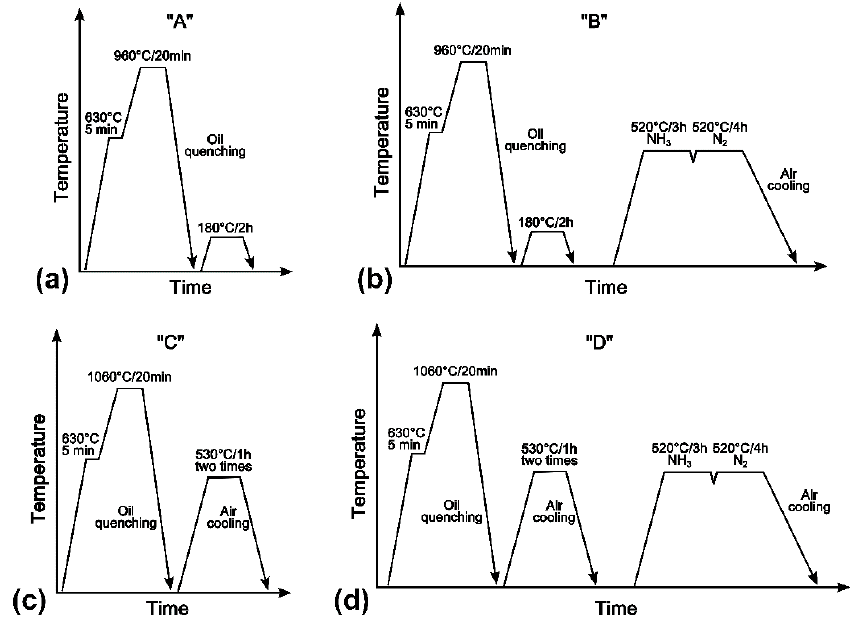
Figure 1. Schematic representation of individual processing treatments of X210Cr12 tool steel: regime “A”, involving lower temperature quenching and tempering for primary carbides preservation within fine ‐ grain microstructure ( a ); regime “B”, involving the combination of regime “A”